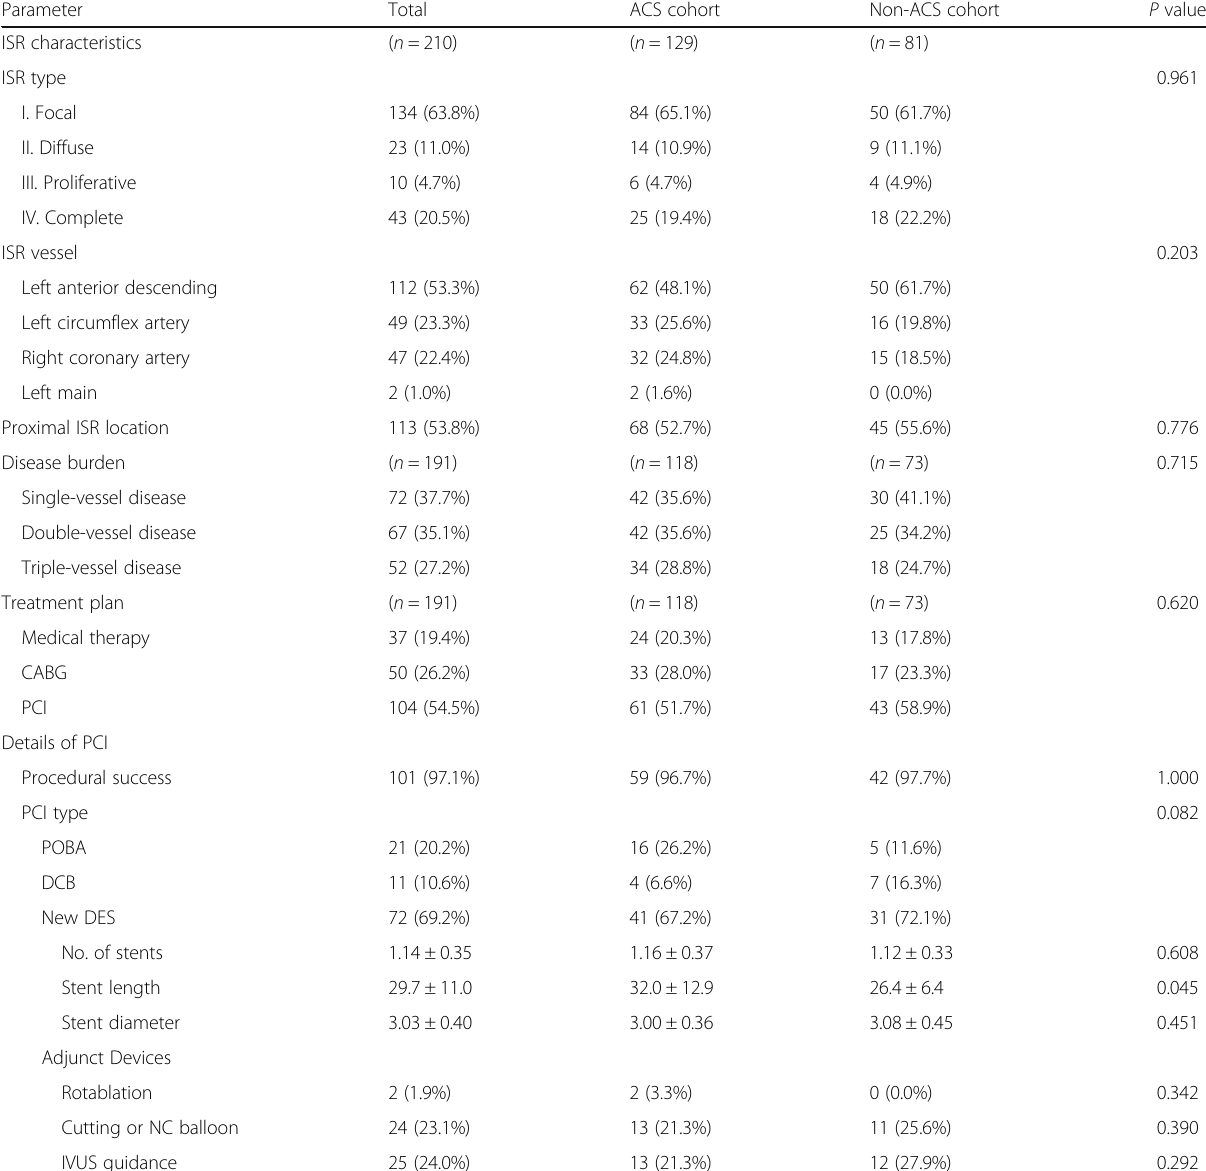
Table 2 Angiographic characteristics and treatment characteristics at first clinical ISR presentation Parameter Total ACS cohort Non-ACS